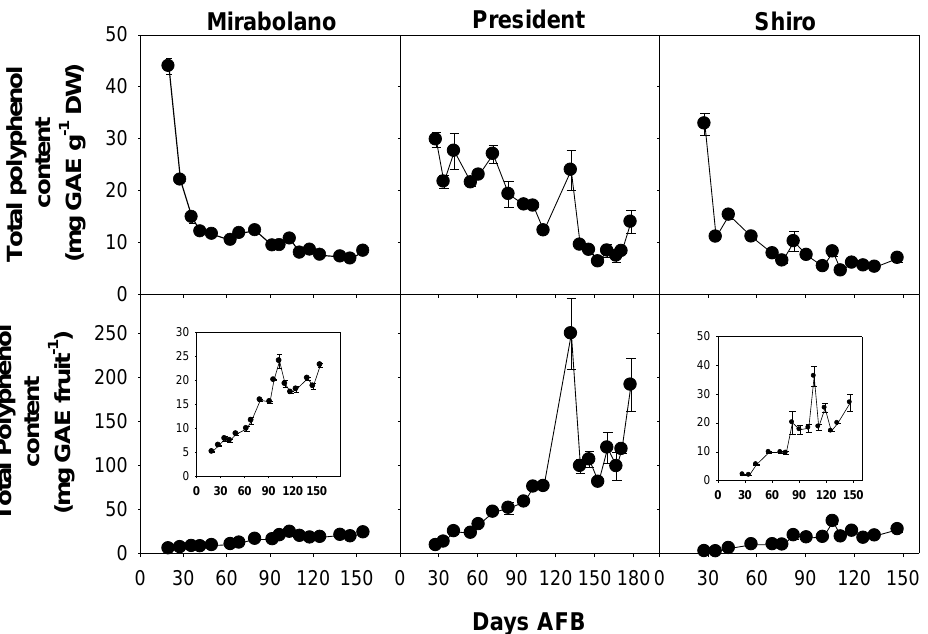
Figure 5. Total polyphenol contents of the flesh (mesocarp + epicarp) of fruits of Prunus cerasifera —Mirabolano, Prunus domestica —cultivar President, and Prunus salicina —cultivar Shiro at different stages of development. Each point on the graph shows the mean and standard error, n = 3. AFB = after full bloom.